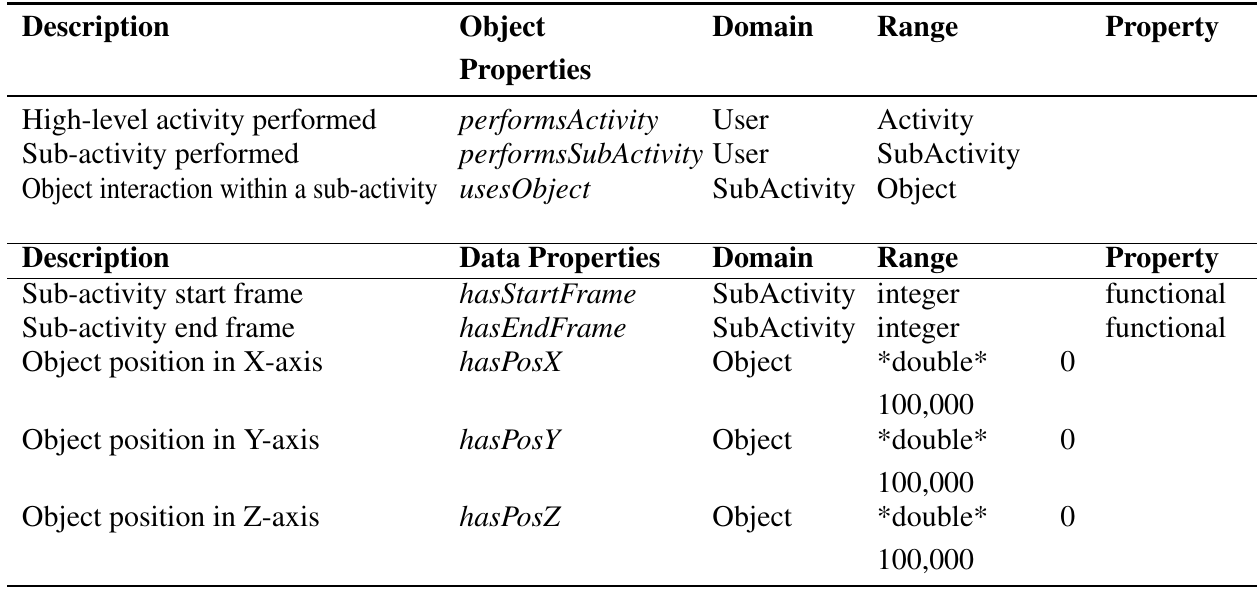
Table 11. Fuzzy roles (ontology object and data